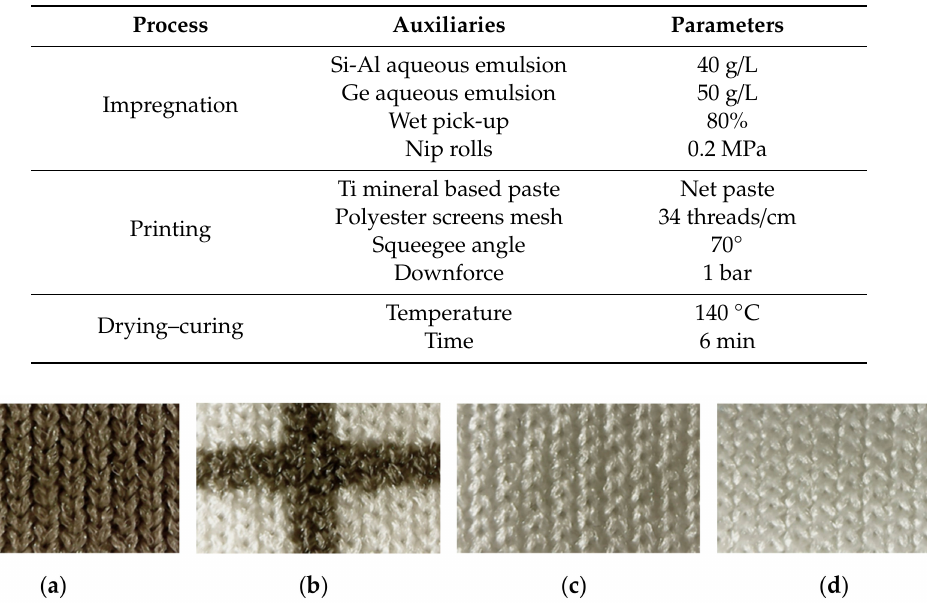
Table 2. Parameters of impregnation, printing and drying–curing processes.